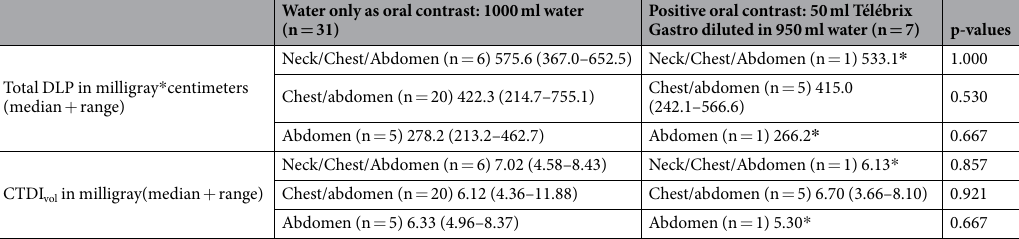
Table 3. Radiation exposure in patients per region scanned by 128 and 2 * 192 slice scanners. All data were non- normally distributed and therefore Mann-Whitney test was performed to compare the distribution between the two arms. * n = 1, therefore no range can be given.